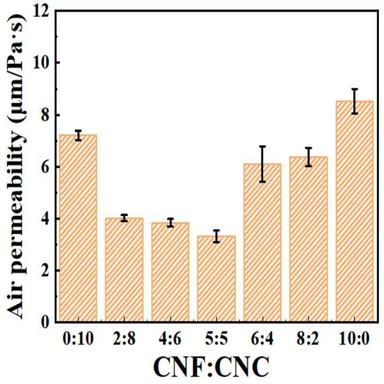
Air permeability of nanocomposite films with different ratios of CNF/CNC.